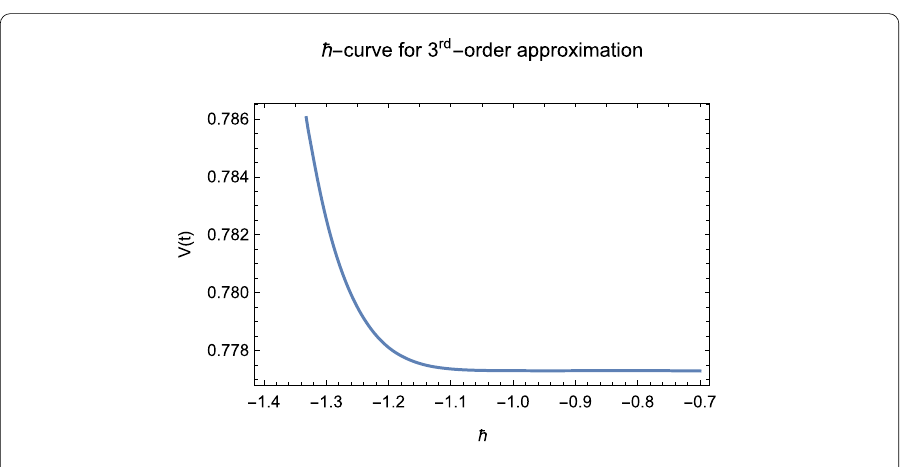
Figure 4 The h -curves of the third-order approximations for V ( t )